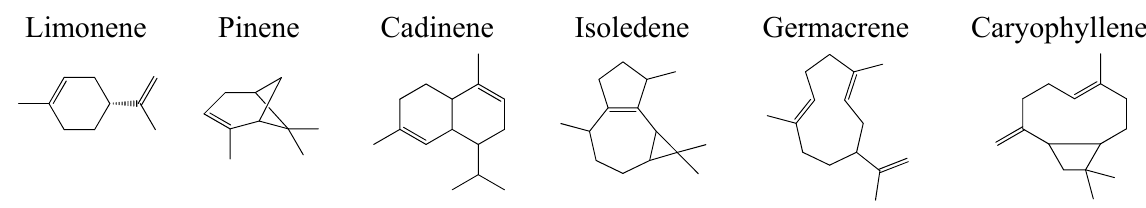
Figure 1. Precursors of mono- and